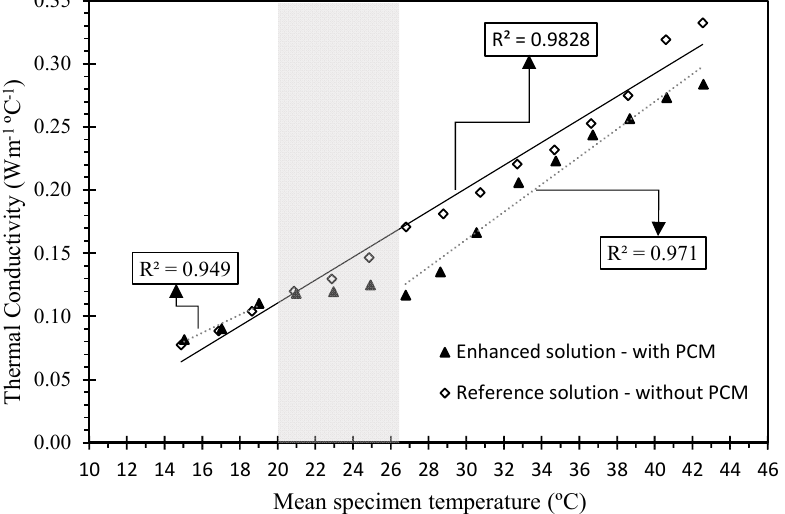
Figure 11. Equivalent thermal conductivity as function of the mean specimen temperature for both construction solutions.